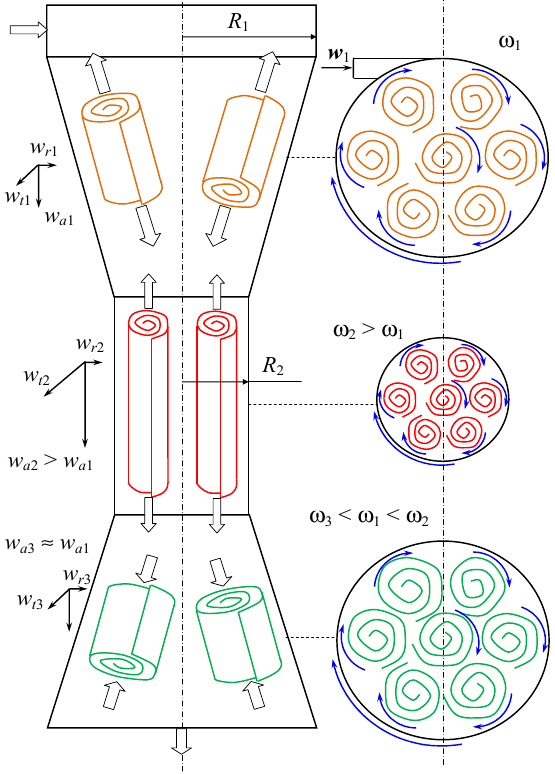
Figure 4. Variation of the axial, tangential, and radial velocity projections and vorticity along the axis of the microreactor with swirling flows. R —radius, m; w a , w t , w r —axial, tangential and radial components of liquid velocity, m/s; w—velocity vector, m/s; ω —vorticity, 1/s; 1, 2, 3—indexes referred to different parts of the microreactor.